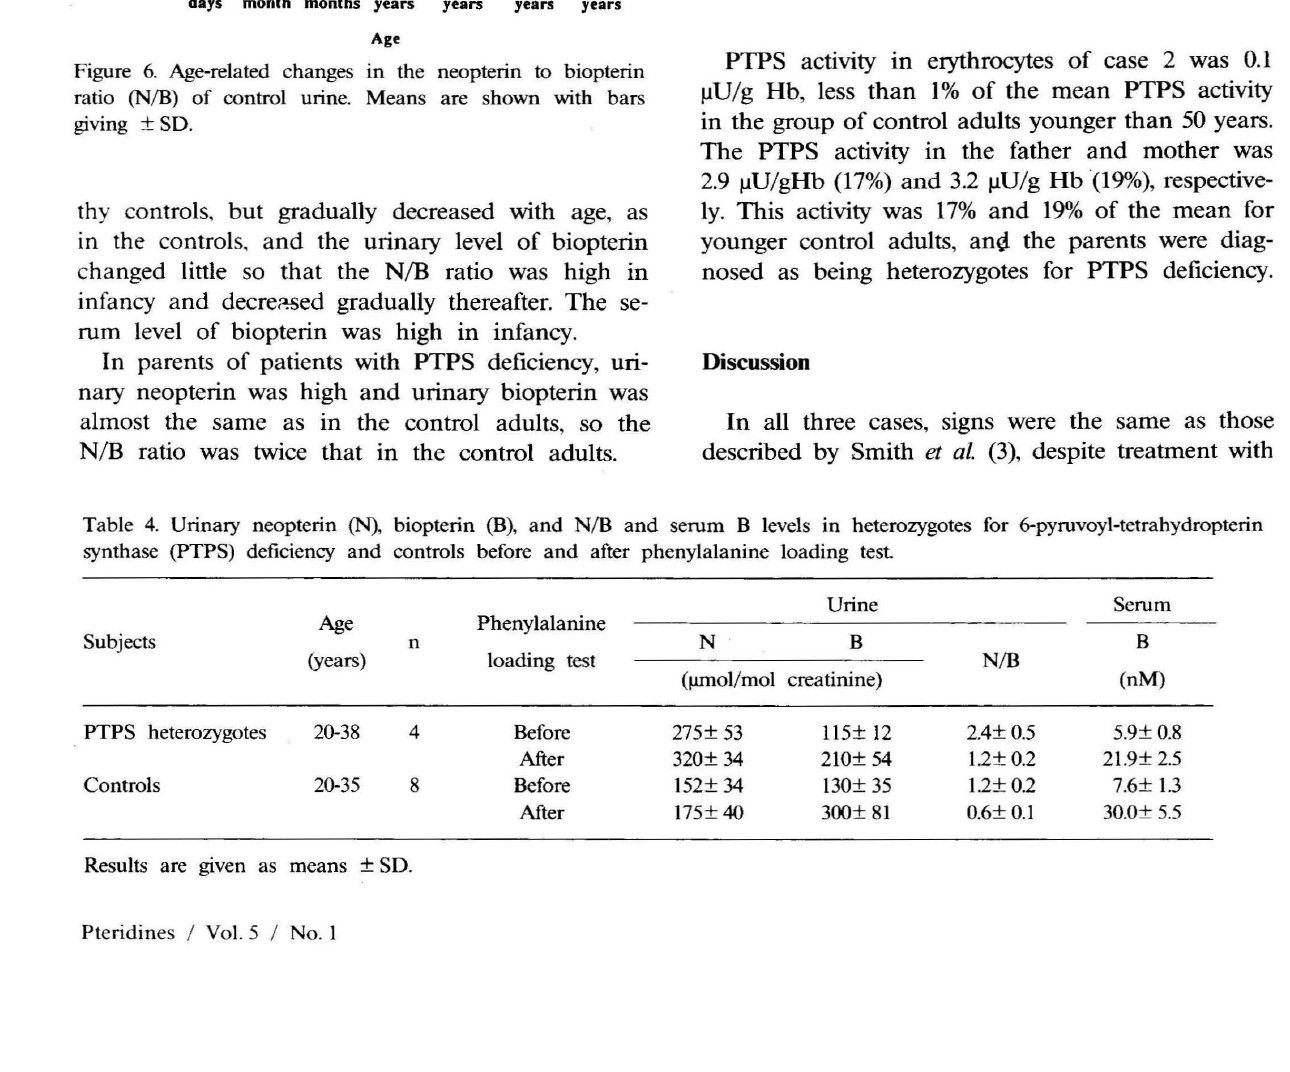
Figure 7. Serum biopterin levels in controls measured by a Crithidia bioassay. Means are shown with bars giving ± SD.